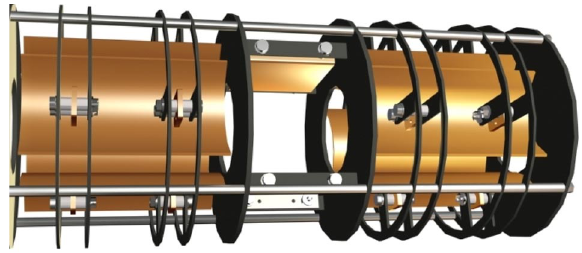
FIG. 11. (Color) Electrostatic quadrupole doublet with inte- grated